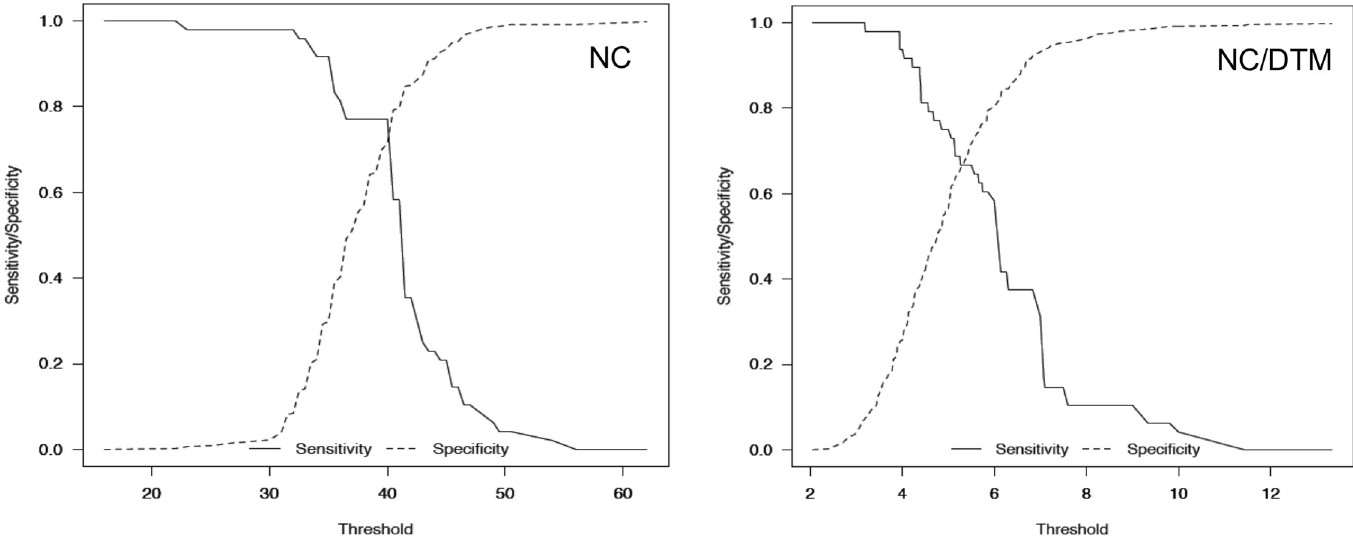
Fig 5. Values for sensitivity and specificity for neck circumference (NC) measurement with a 40-cm cut-off value and ratio of the NC to thyromental distance (NC/ TMD) test with a cut-off value of 5.85.